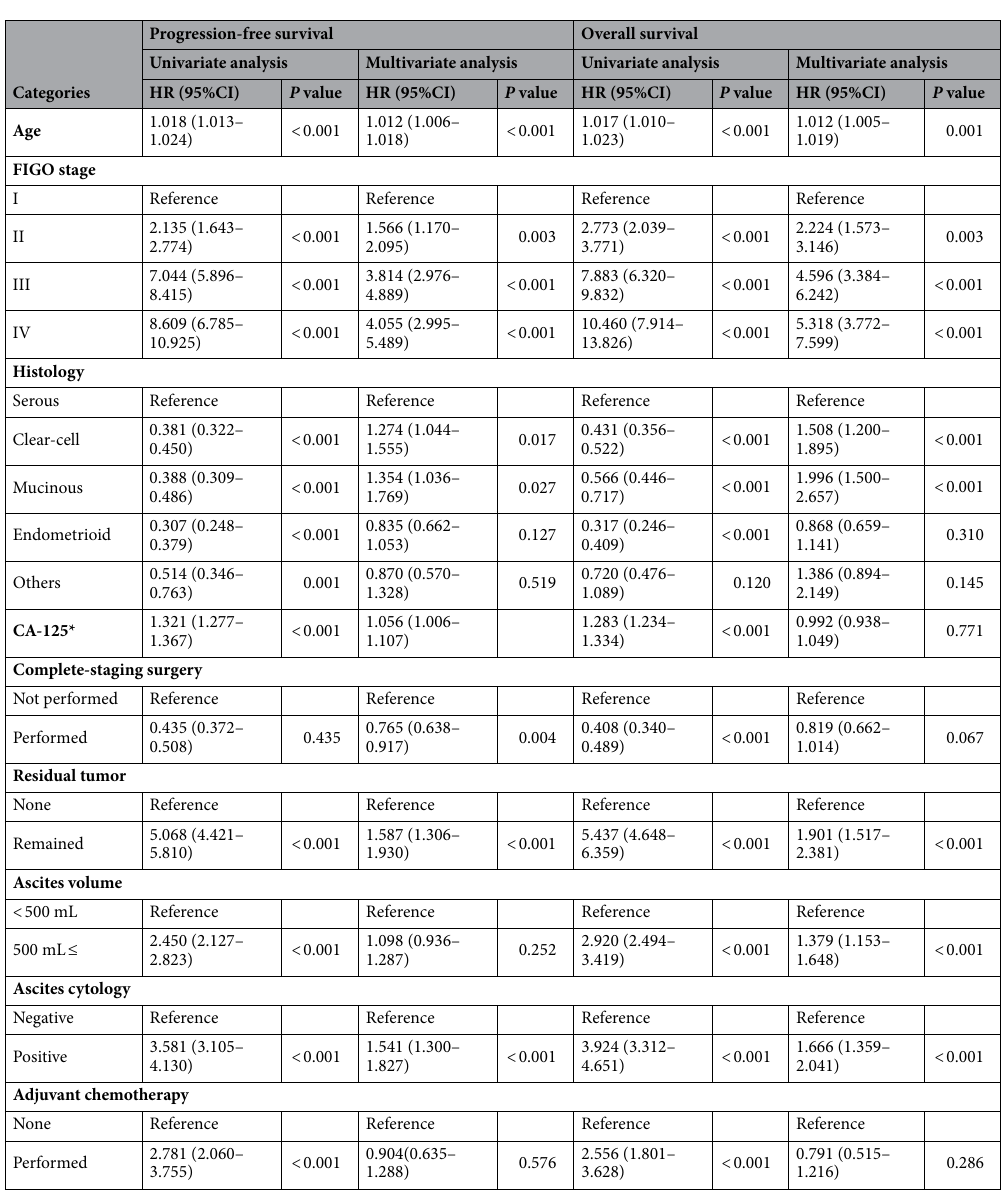
Table 2. Uni- and multivariate analysis for survival outcomes of the patients. CA cancer antigen, HR hazard ratio, CI confidence interval. *Logarithmic transformed when